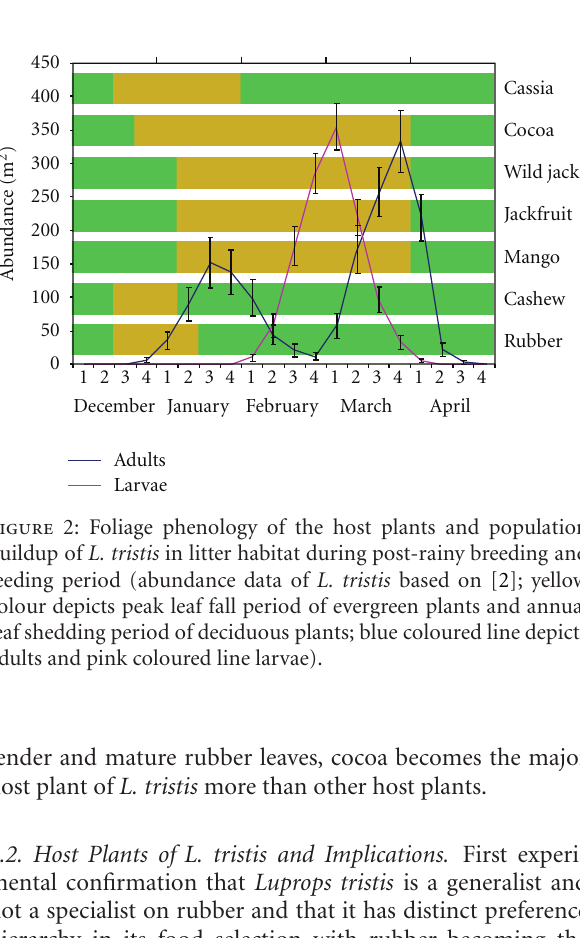
Figure 1: Aggregated beetles on the wall of a residential building.